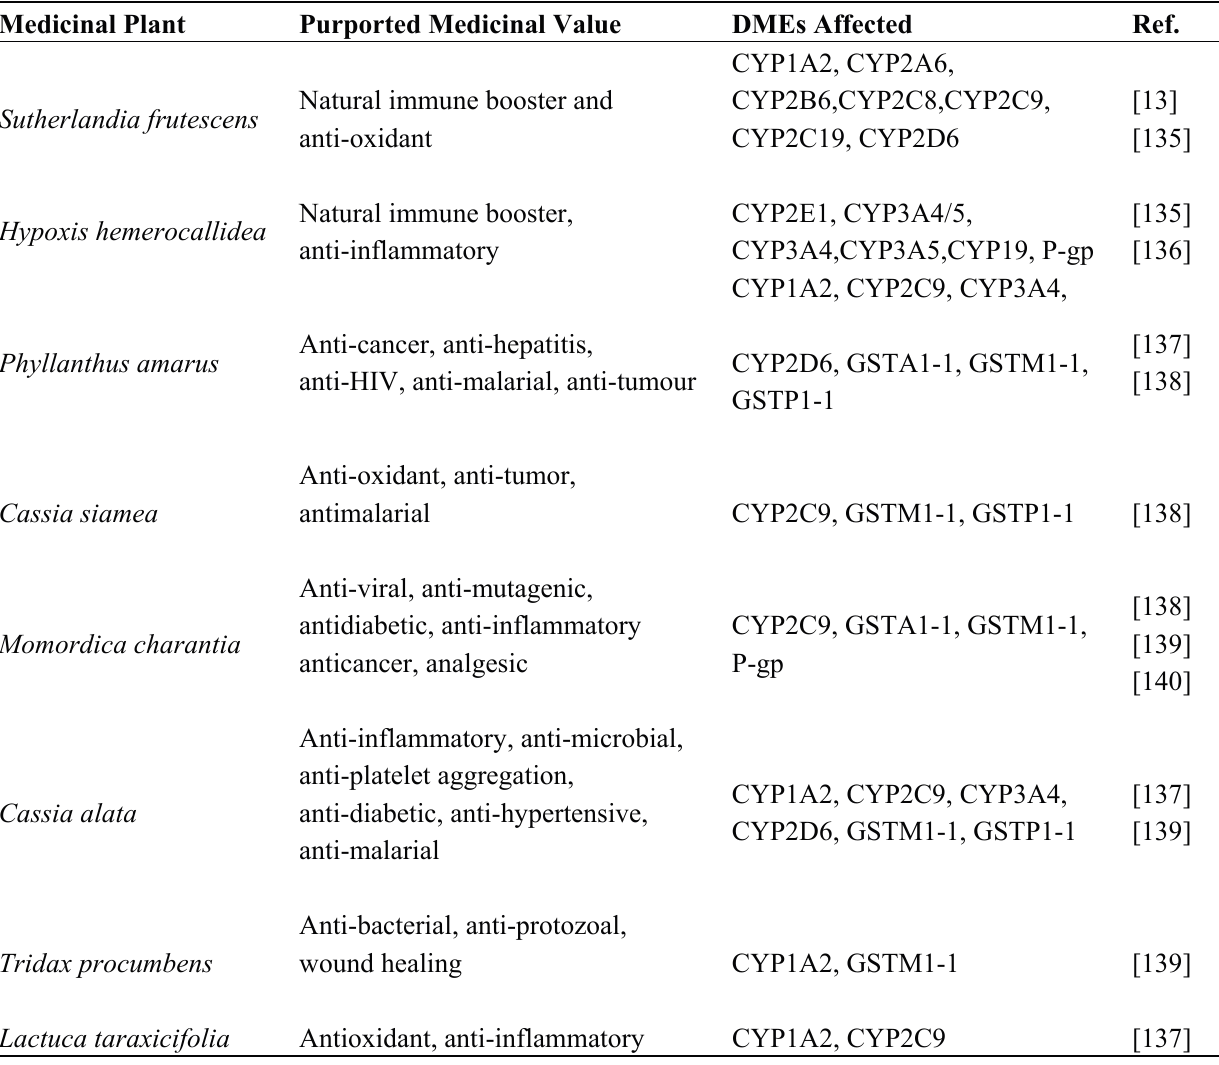
Table 2. Commonly used herbal plants in Southern and West African countries that interact with drug metabolizing enzymes